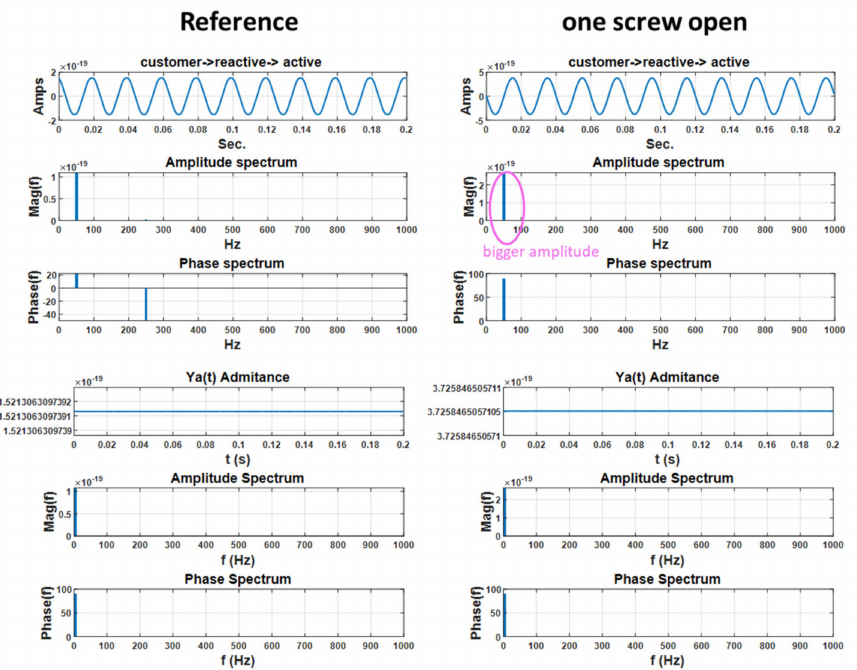
Figure 19. ‘customer → reactive → fixed’ current and admittance are small but not entirely zero (10 − 19 ) . Reflects that reactive component Equation (24) C n = 0 (capacitance at reactive